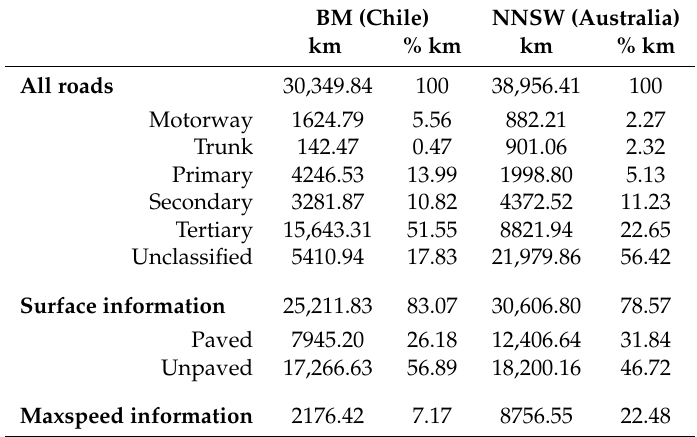
Figure 5. Boxplots of the speed distribution per road class of the reference data for ( a ) the BioBío and Maule (BM) regions (Chile) and ( b ) the north of New South Wales (NNSW) (Australia). Road classes: MW— Motorway , TR— Trunk , PR— Primary , SC— Secondary , TE— Tertiary , UC— Unclassified . The red diamonds in the boxes symbolize the respective median, the red lines the respective mean value. The lower limit of each box is the 25 th percentile ( Q 1), the upper limit the 75 th percentile ( Q 3) so that the difference builds the interquartile range ( IQR ). Whiskers extend to Q 1 − 1.5 ∗ IQR and Q 3 + 1.5 ∗ IQR . Any points beyond the whiskers are outliers and are plotted as circles. Table 2. Overview of the OSM data in the BM regions in Chile and NNSW in